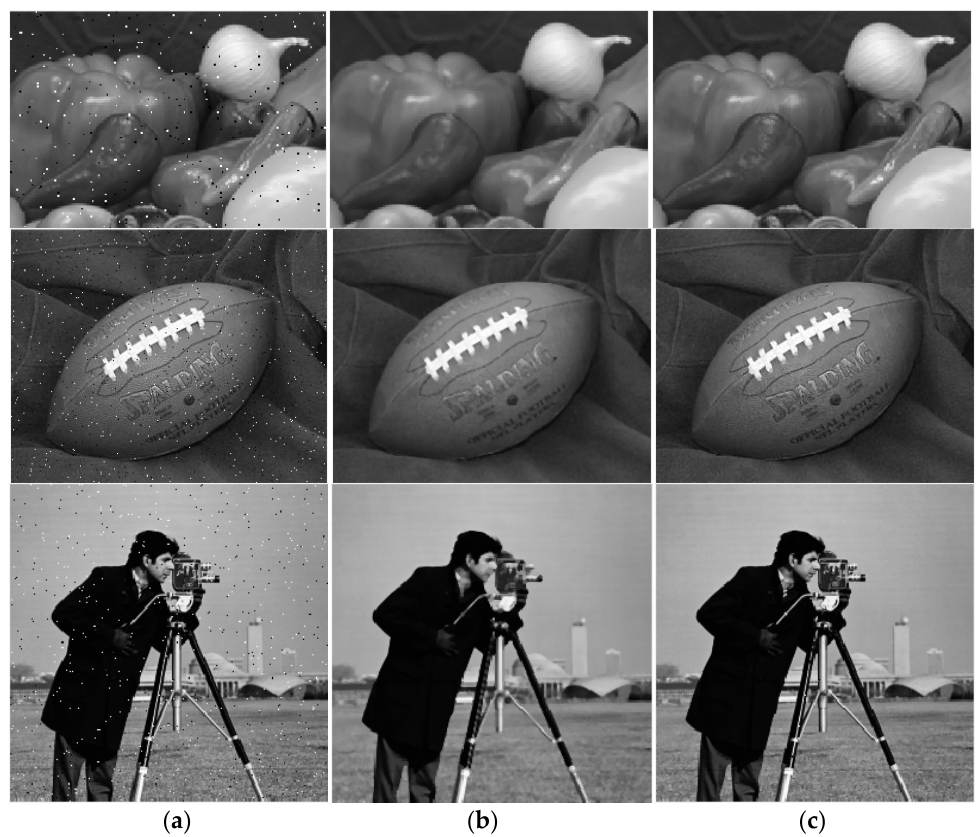
Figure 10. Noise images (density: 0.01) and filtered images: ( a ) Noise Image with density of 0.01; ( b ) Image processed by median filtering; ( c ) Image processed by normal distribution operator filtering